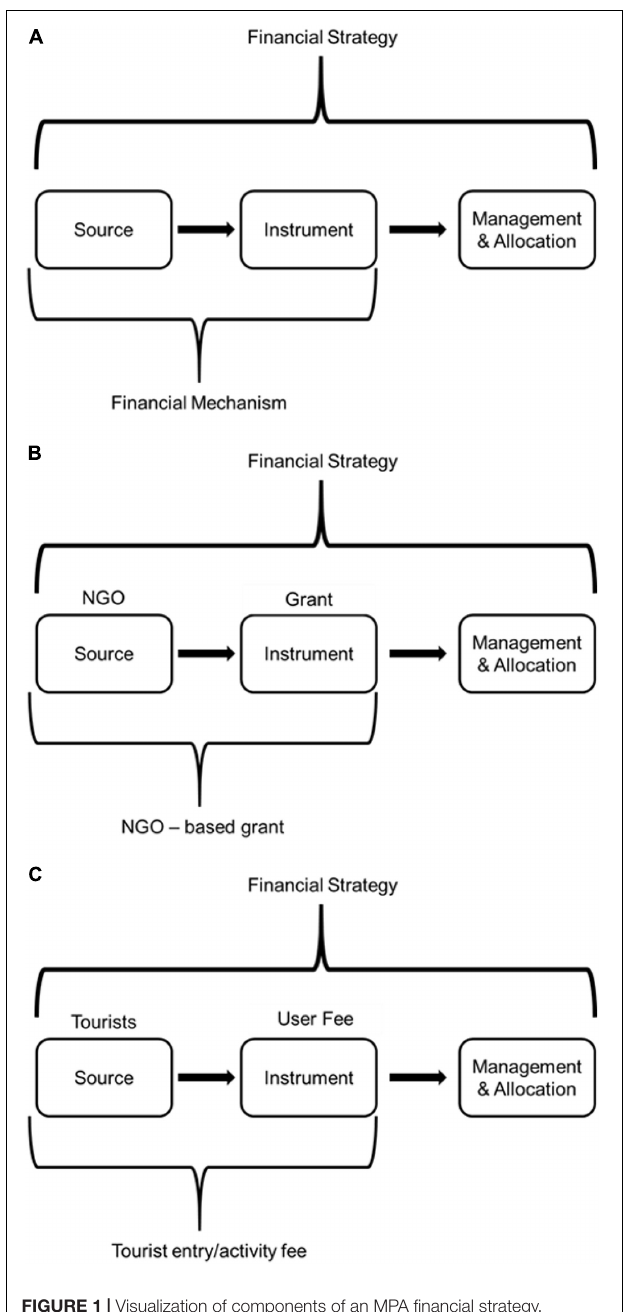
FIGURE 1 | Visualization of components of an MPA financial strategy, depicting (A) the theoretical approach, (B) example for NGO grants, and (C) example for entry or user fees for